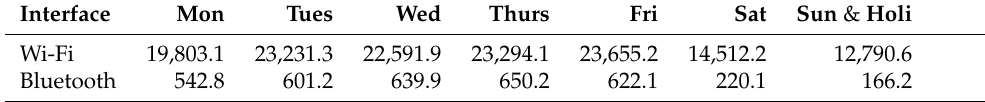
Table 2. Average number of devices sensed per day grouped by sensor type.